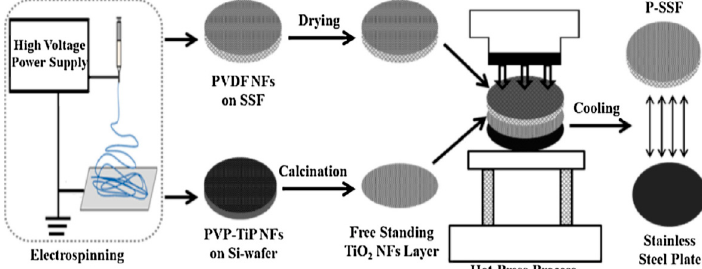
Figure 5. Schematization of the preparation process used for preparing the stainless steel filter PMs (SSF PMs) [80].